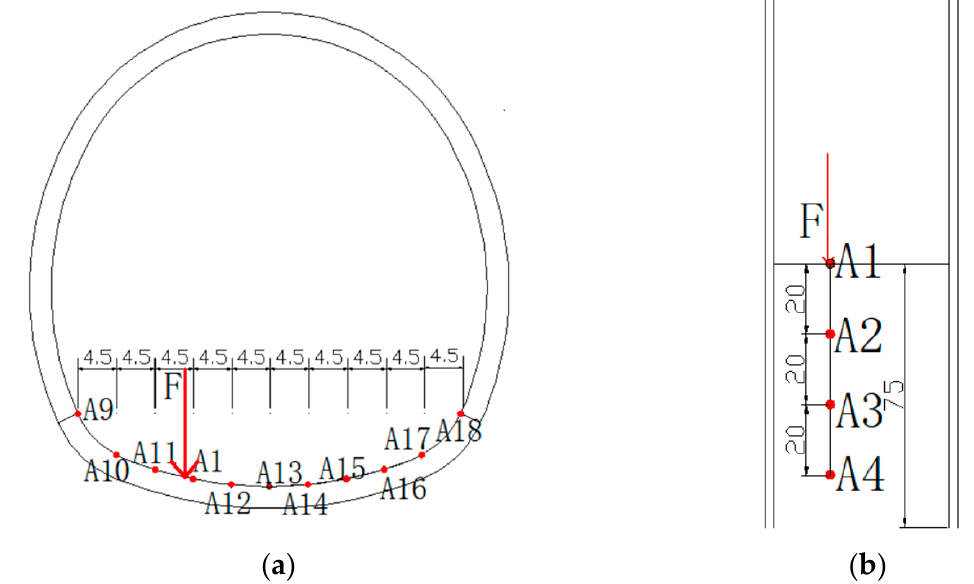
Figure 7. The layout of the acceleration sensor in the tunnel (cm): ( a ) annular layout; ( b ) axial layout on the tunnel invert.